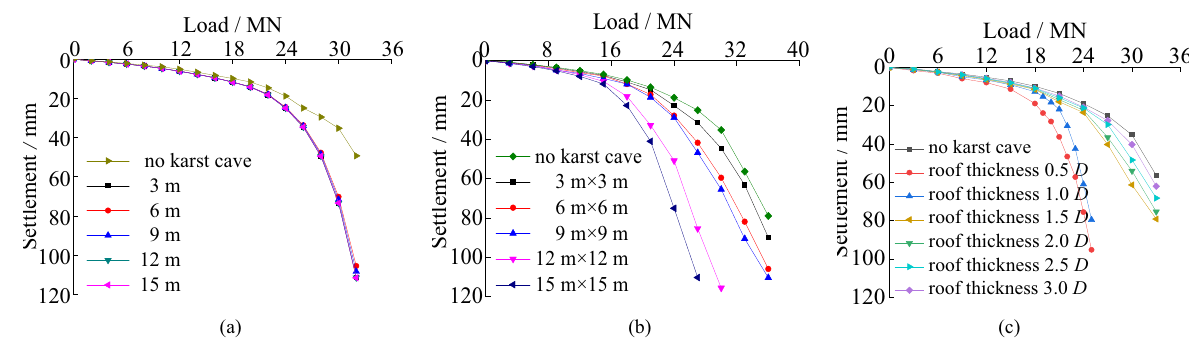
Figure 8. The load–settlement curves under three factors: ( a ) different cave’s height; ( b ) different cave’s span; ( c ) different cave’s roof thickness.